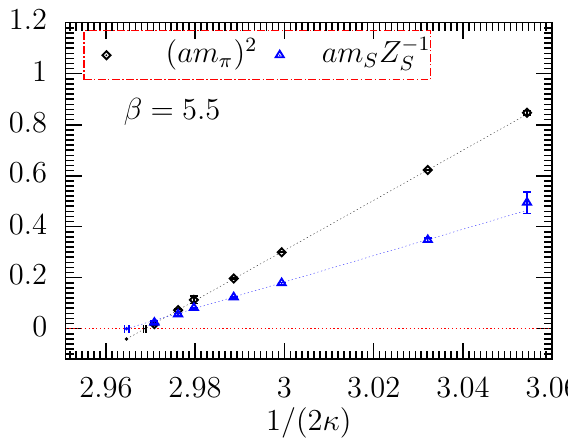
Figure 1. Linear extrapolations of the adjoint pion mass squared ( m 2 gluino mass ( am S Z − 1 ) obtained by SUSY Ward identities (blue) as a function of the bare parameter S κ towards the chiral point ( κ c